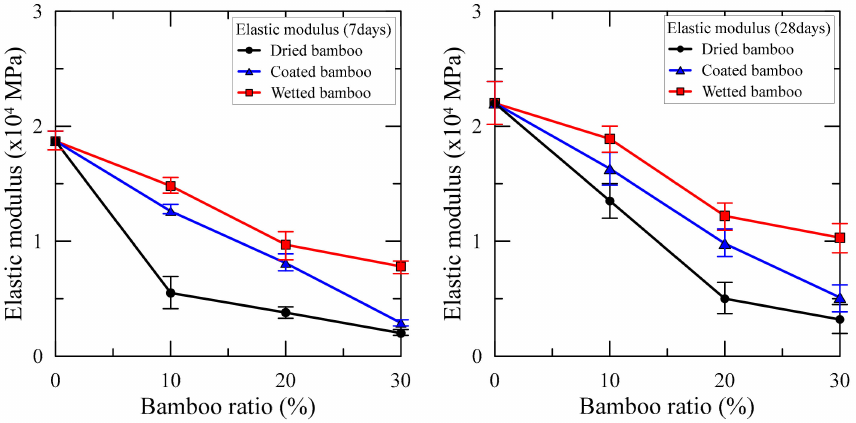
Figure 7. Elastic modulus of specimens with di ff erent bamboo chips.